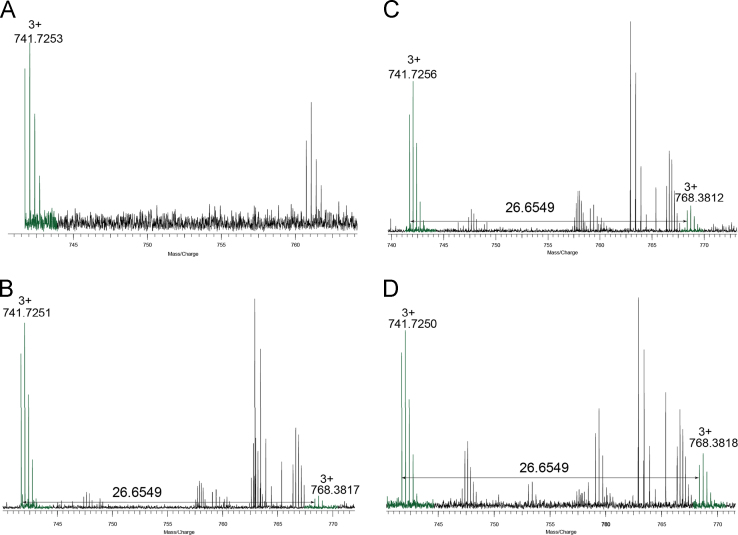
FTICR MS of peptide 366–385 (366FCIKHIATNAVLFFGRC VSP385) at m/z 741.723+ from natural Oval (A) and P-Oval incubated for 1 day (B), 2 days (C), and 5 days (D). Phosphorylation is indicated by a mass increase of 79.9663 Da.